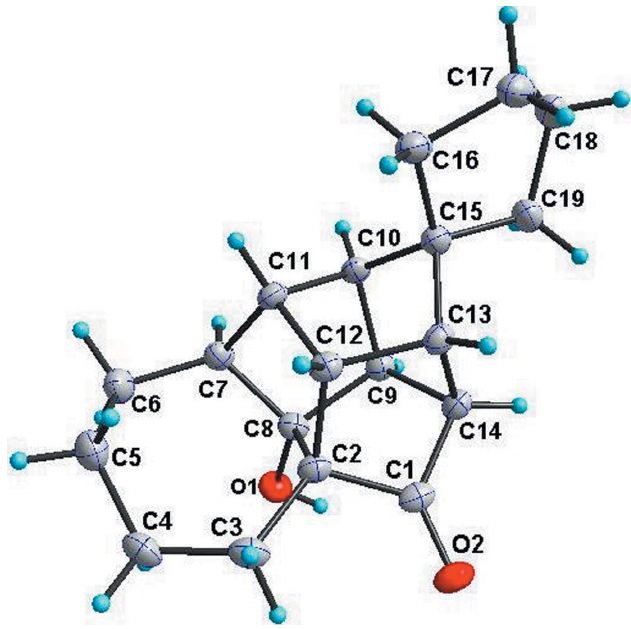
Figure 1 The molecular structure of the title compound, showing the atom- numbering scheme. Displacement ellipsoids are drawn at the 50% probability level.